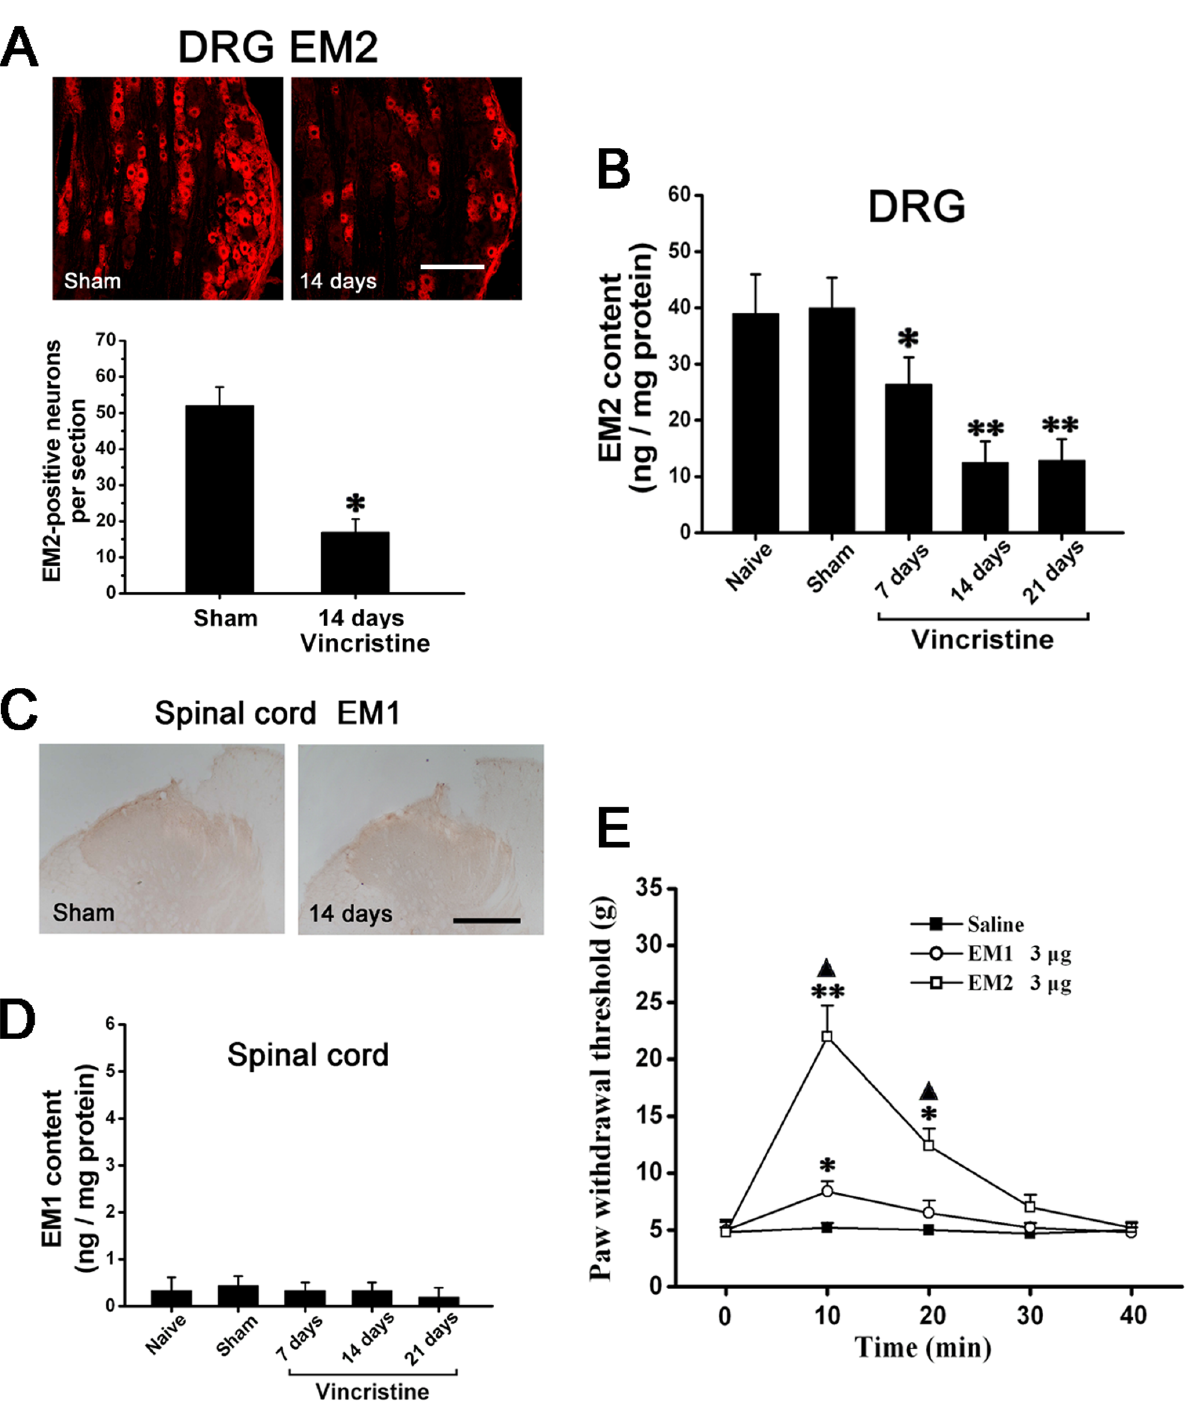
Figure 3. EM2 in dorsal root ganglion was significantly decreased, and there was almost no spinal EM1 in vincristine treated rats. (A) The number of EM2-immunopositive dorsal root ganglion neurons in Vincristine group was significantly decreased compared to Sham group. Bar=100 m m. (B) Compared to Naive group and Sham group, ELISA showed that the EM2 content of dorsal root ganglion was significantly decreased in Vincristine group. (C) There was almost no EM1-immunopositive structures in spinal cord in Sham group and Vincristine group. (D) ELISA showed that the spinal cords of all the rats contained almost no EM1. (E) EM2 showed more effective antinociception than EM1. *P , 0.05, **P , 0.01 vs. Naive group and Sham group in (A) and (B). *P , 0.05, **P , 0.01 vs. Saline group; m P , 0.05 vs. EM1 group in (E).